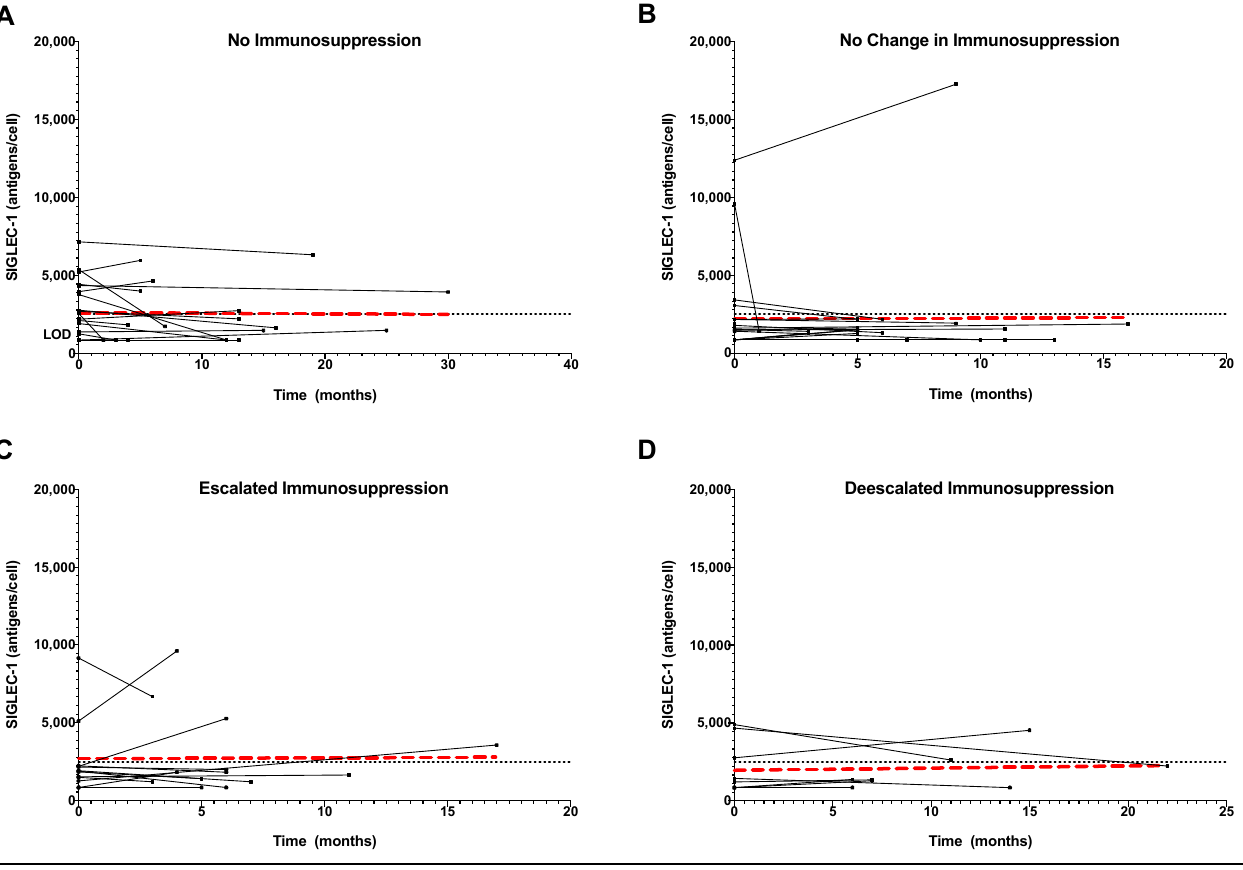
Figure 2. Longitudinal analysis of SIGELC-1 expression of Systemic Sclerosis (SSc) patients without receiving immunosuppression ( A ), with unchanged immunosuppression ( B ), and with escalated ( C ) or deescalated ( D ) immunosuppressive therapy. The red dashed line represents the trend of all patients in the respective SSc group.